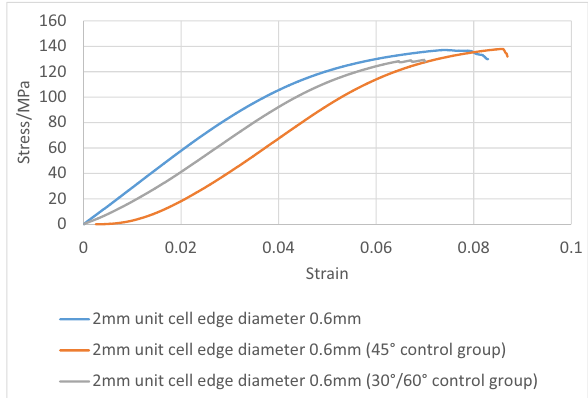
Figure 21: Stress – strain curves of 1.5 mm unit cell with 0.4 mm edge diameter samples at di ff erent angles.